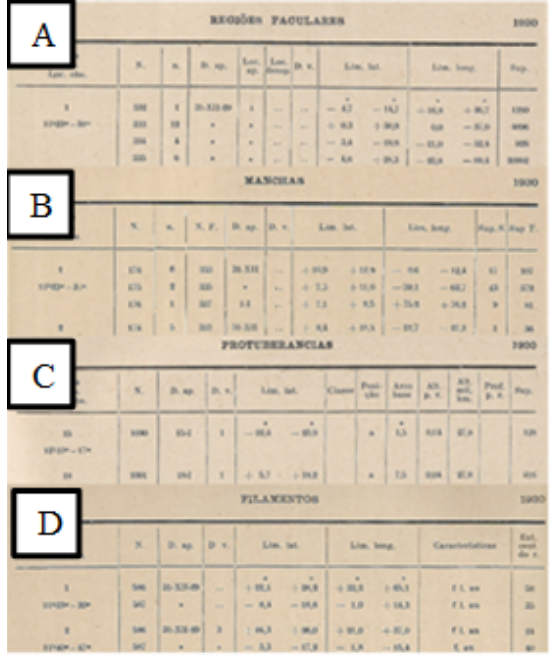
Figure 13. A composite image showing the types of charts published in the COI catalogue: facular regions (A), sunspots (B) prominences (C), and filaments (D) [Source: Lobo